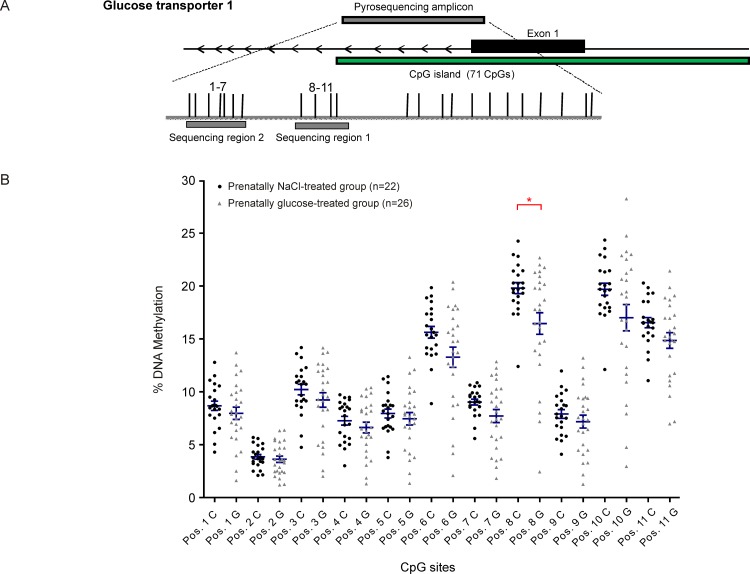
Glucose transporter 1 (GLUT1).Schematic illustration of sequence map of the glucose transporter 1 (GLUT1) gene promoter region with chromosomal location of pyroassay (A), and corresponding DNA methylation levels at individual CpG sites for prenatally NaCl-treated controls (black) and the prenatally glucose-treated group (gray) (B).* p<0.05 (Mann-Whitney U-test)